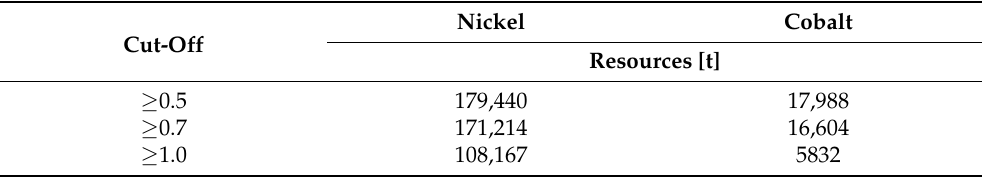
Table 9. Resources of useful elements estimated by the polygon method (Boldyrev) for the whole identified area. Nickel Cut-Off